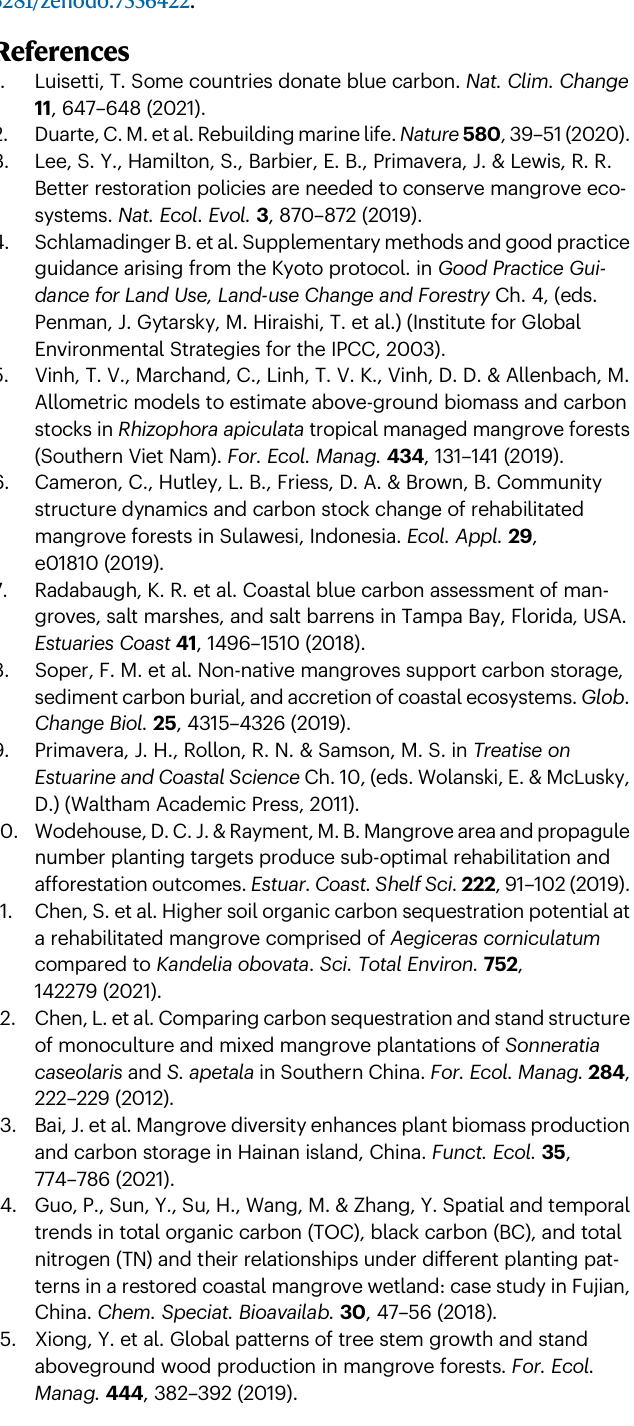
mangrove area dataset (Global mangrove watch 1996 and 2016) is calculation process of climate mitigation potential from